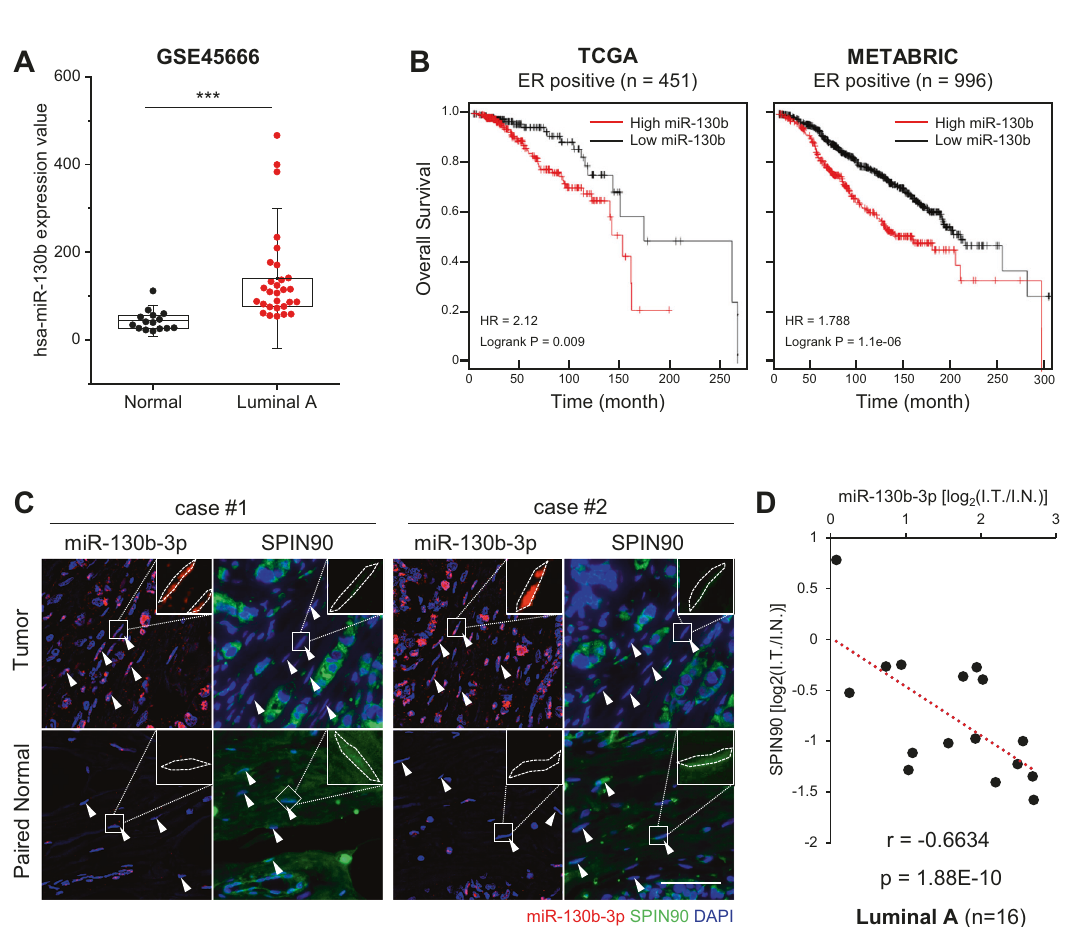
Fig. 6 Expression of miR-130b-3p in CAFs derived from human breast cancer tissue is inversely correlated with that of SPIN90. A Expression of miR-130b in human luminal A breast cancer ( n = 29) and normal tissues ( n = 15) from the GSE45666 dataset. *** p ≤ 0.001 (Student ’ s t -test). B KM-plot survival analysis for ER-positive patients with respect to miR-130b expression. The data were retrieved from the TCGA ( n = 451) and METABRIC ( n = 996) datasets. HR hazard ratio. C Representative images of miR-130b-3p (red) and SPIN90 (green) staining in serial tissue sections from a tumor microarray (BR804b). Tumor and paired normal tissues from luminal A breast cancer patients ( n = 16) were analyzed. The enlarged images at the upper right were not merged with DAPI. Cell boundaries are marked with white dotted lines. White arrows indicate stromal fi broblasts. Scale bar, 50 μ m. D Correlation between the expression levels of miR-130b-3p and SPIN90 in the stroma. Each value was calculated as the log ratio of [intensity in tumor stroma] relative to [intensity in normal stroma] using ImageJ